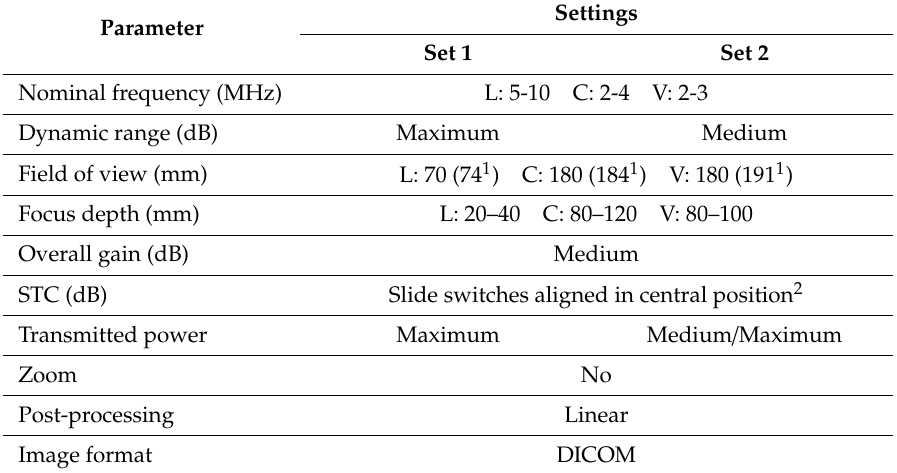
Table 2. Ultrasound system